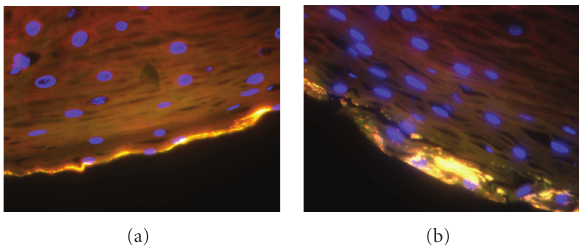
Figure 7: Vaginal biopsy from a subject with BV. A Gardnerella vaginalis biofilm (yellow) is detected at the edge of the vaginal epithelium (bottom) by fluorescence in situ hybridization (FISH). The yellow color is the result of using a combination of probes targeting G. vaginalis (Red), all bacteria (Eub338, green), and 4 (cid:3) ,6- diamidine-2-phenylindole, dihydrochloride (DAPI, blue) which stains DNA. Note human cell nuclei in blue. The image on the right shows a vaginal epithelial cell with a cluster of G. vaginalis breaking o ff the epithelium and likely forming a clue